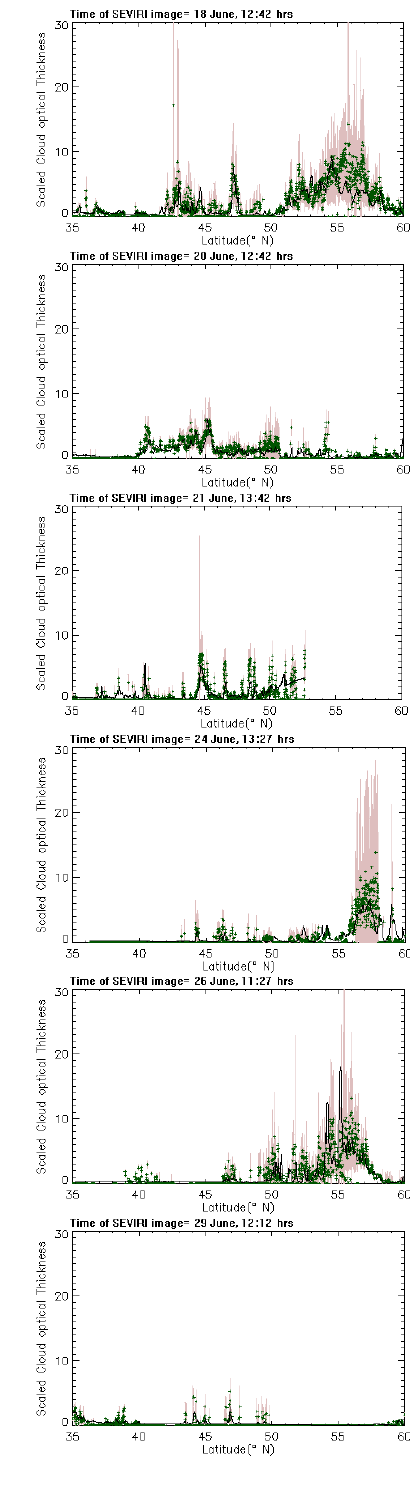
Fig. 4. Scaled cloud optical thickness ( τ ∗ ) retrieved from our approach (continuous black curve) and from CloudSat (green symbols). The uncertainity in the CloudSat values are given by the shaded